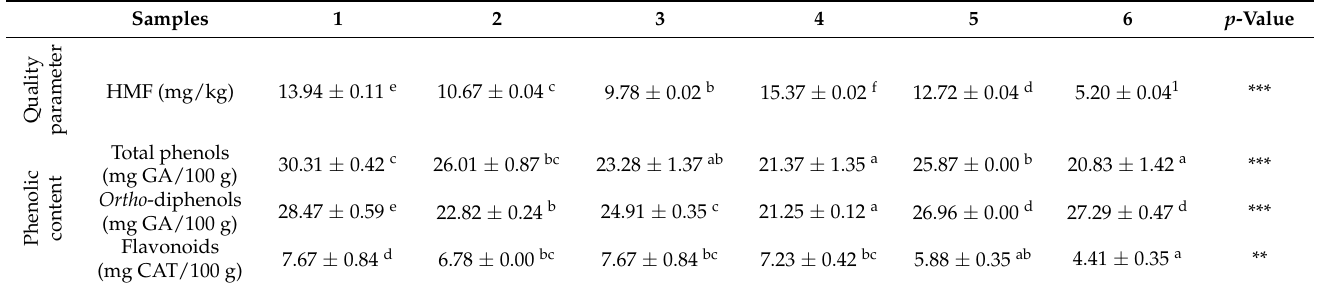
Table 2. Quantification of HMF by HPLC-UV (mg/kg) and phenolic content (total phenols (mg GA/100 g), ortho -diphenols (mg GA/100 g), and flavonoids (mg CAT/100 g)